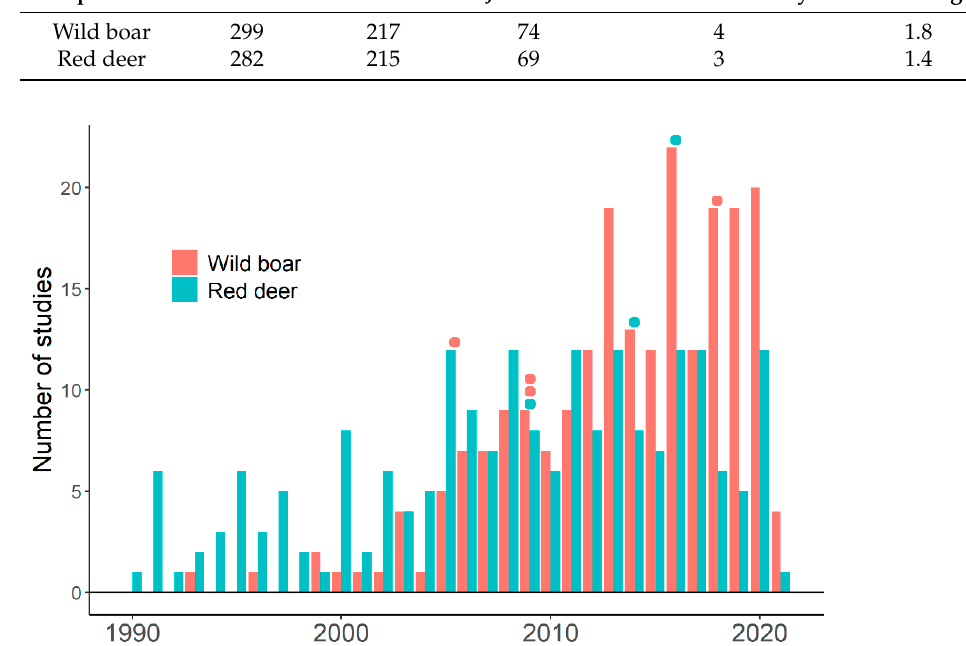
Figure 2. Studies on tuberculosis in wild boar and red deer populations from 1990 to April 2021. Results from the search on the Web of Science described in Table 1 (Selected papers). Colored points indicate the year in which studies explicitly relating tuberculosis to reservoir genetic diver- sity were published. Red points: studies for wild boar. Blue points: studies for red deer. See Tables S3 and S4.